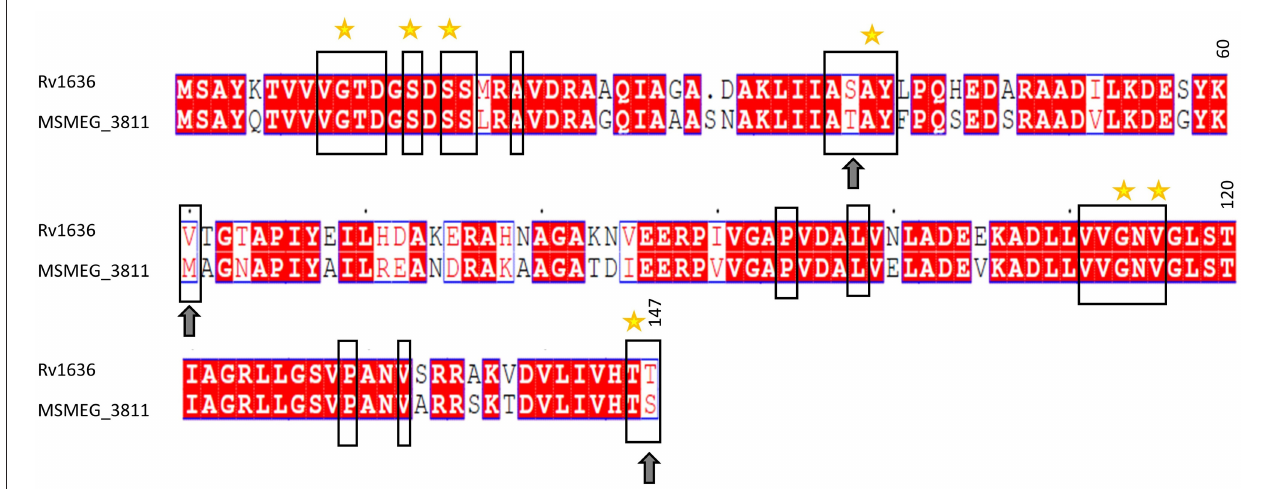
FIGURE 2 | Full-length sequence alignment of Rv1636 ( Mtb USP) and MSMEG_3811 ( M. smegmatis USP). The sequences have been aligned using the EMBL-EBI online tool, EMBOSS (Madeira et al., 2019), and the alignment has been viewed using ESPript 3.0 (Robert and Gouet, 2014). The columns with identical residues are highlighted in red box. Similar residues are indicated in red font. The black rectangles enclose the binding site residues. The yellow stars are placed above the residues that are shown to be hydrogen bonded with cAMP in the crystal structure of PDB code: 5AHW. The arrows indicate non-identical but similar residues in the binding site. The numbers above the residues at the end of each block indicate the particular residue position in the sequence of Mtb USP